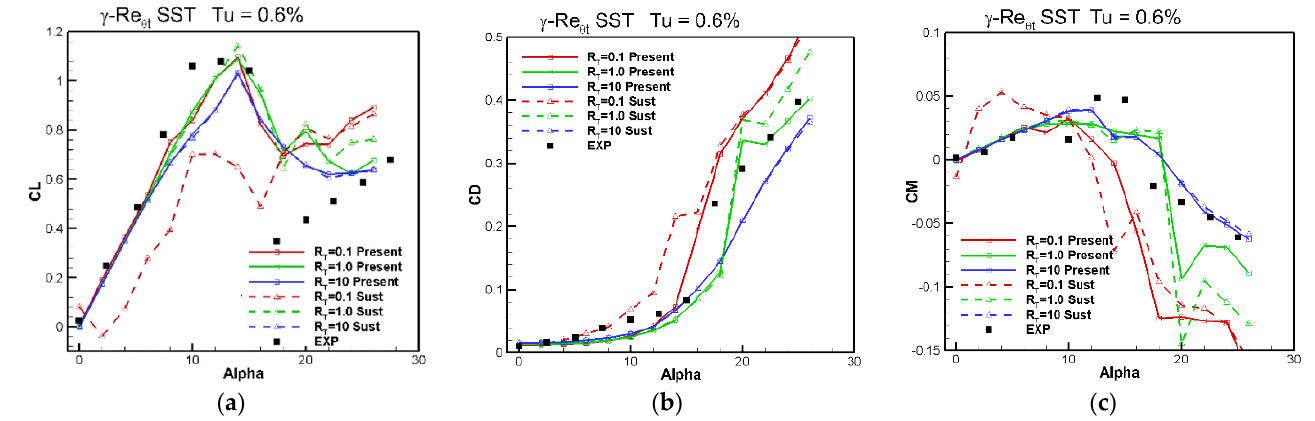
Figure 4. Computed force coefficients predicted by different approaches versus experimental data. ( a ) Lift coefficient vs. AoA. ( b ) D rag coefficient vs. AoA. ( c ) Pitching moment coefficient vs. AoA.